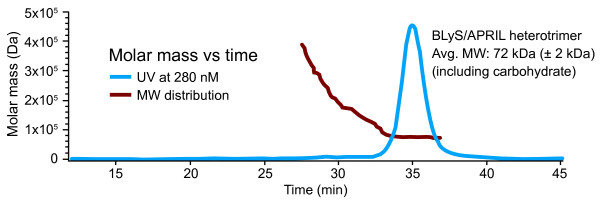
Size-exclusion chromatography with multiangle light-scattering mass distribution of purified HT. Red line, molecular weight species by static light scattering; blue line, BLyS/APRIL HT; APRIL, a proliferation-inducing ligand; BLyS, B-lymphocyte stimulator; HT, heterotrimer; MW, molecular weight.